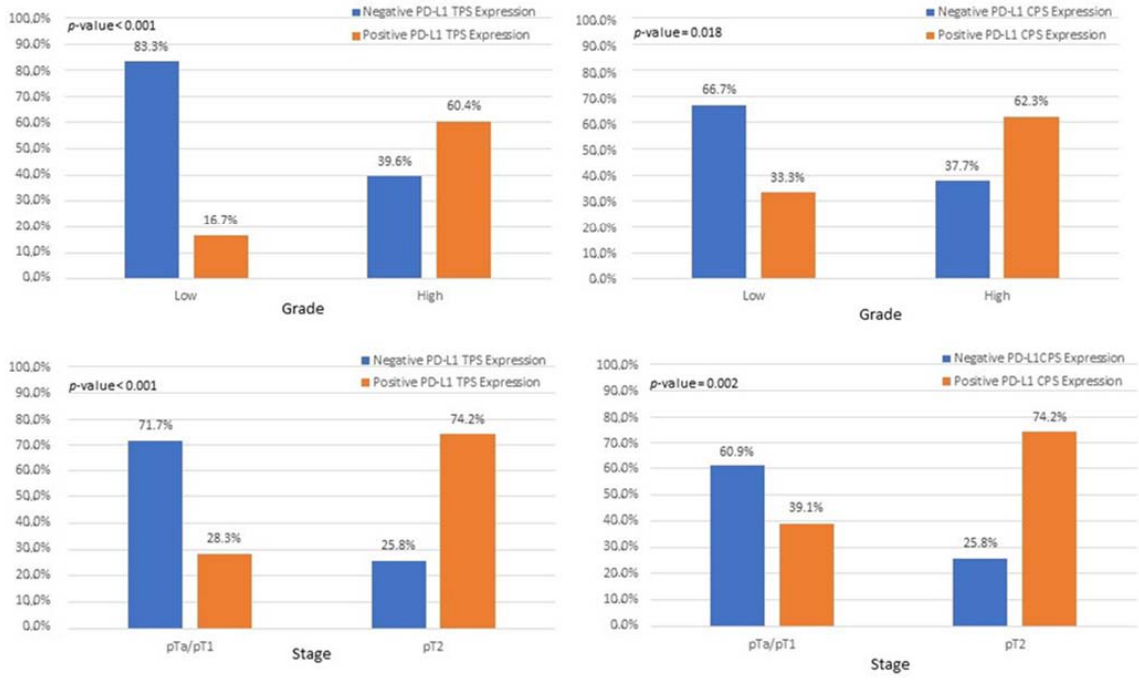
Figure 9. Associations of patients with pTa/pT1 tumors with PD-L1 IC score.